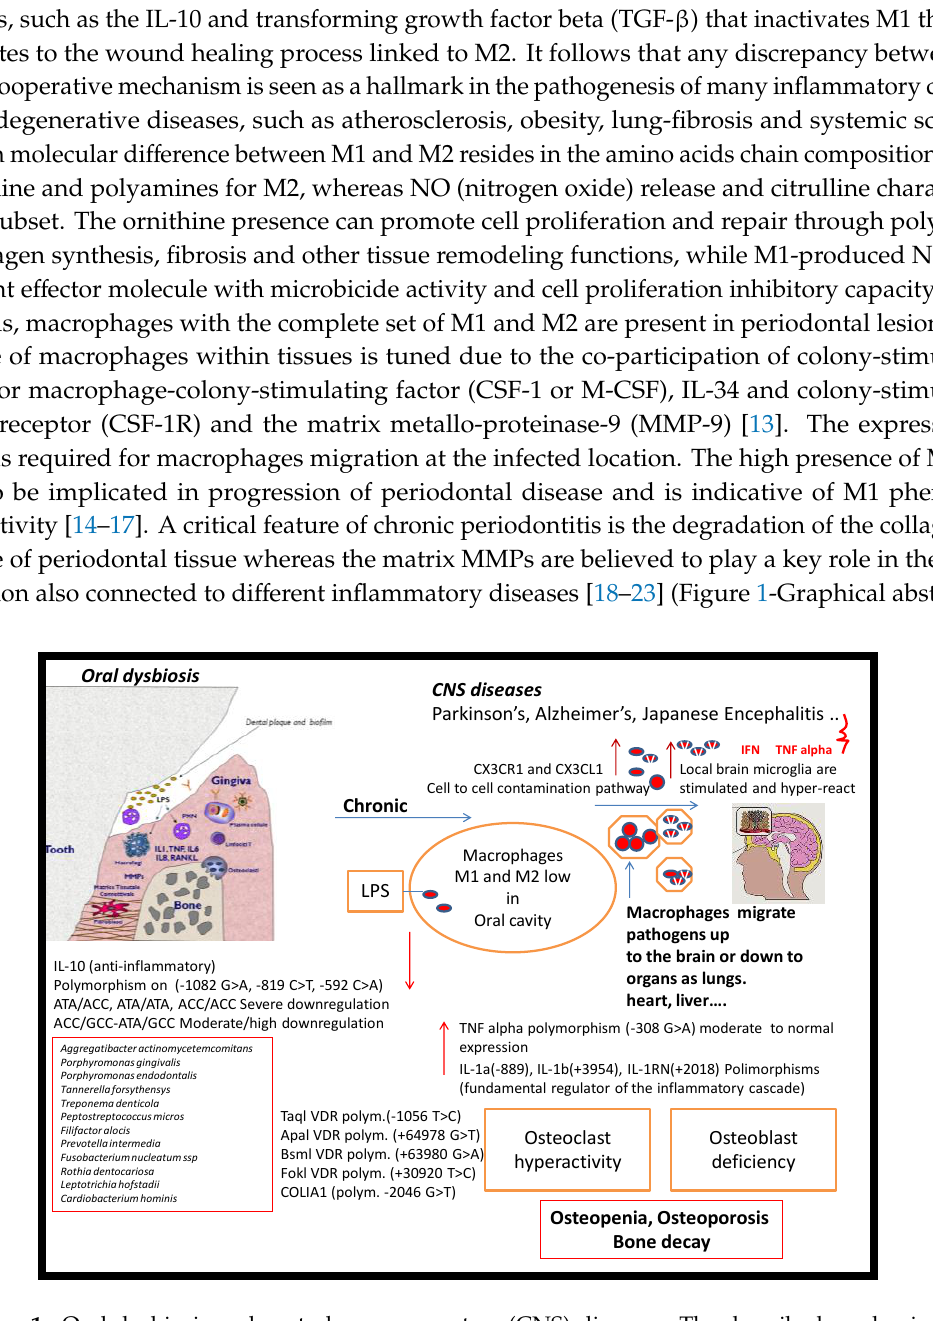
Figure 1. Oral dysbiosis and central nervous system (CNS) diseases: The described mechanisms may be involved in complex interactions among oral dysbiosis and CNS diseases. The central theme of CNS diseases pathogenesis is the presence of brain inflammation as illustrated by increases in pro-inflammatory cytokines, LPS and macrophages polarization. The periodontal-derived pro-inflammatory molecules and bacterial products may reach the brain via systemic circulation and/or neural pathways, contributing to brain inflammation and inflammatory vicious cycle.